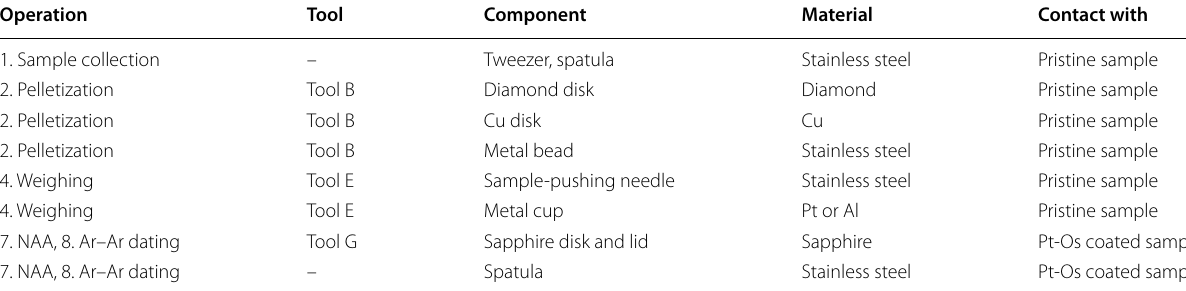
Table 1 List of the sample-intimate components